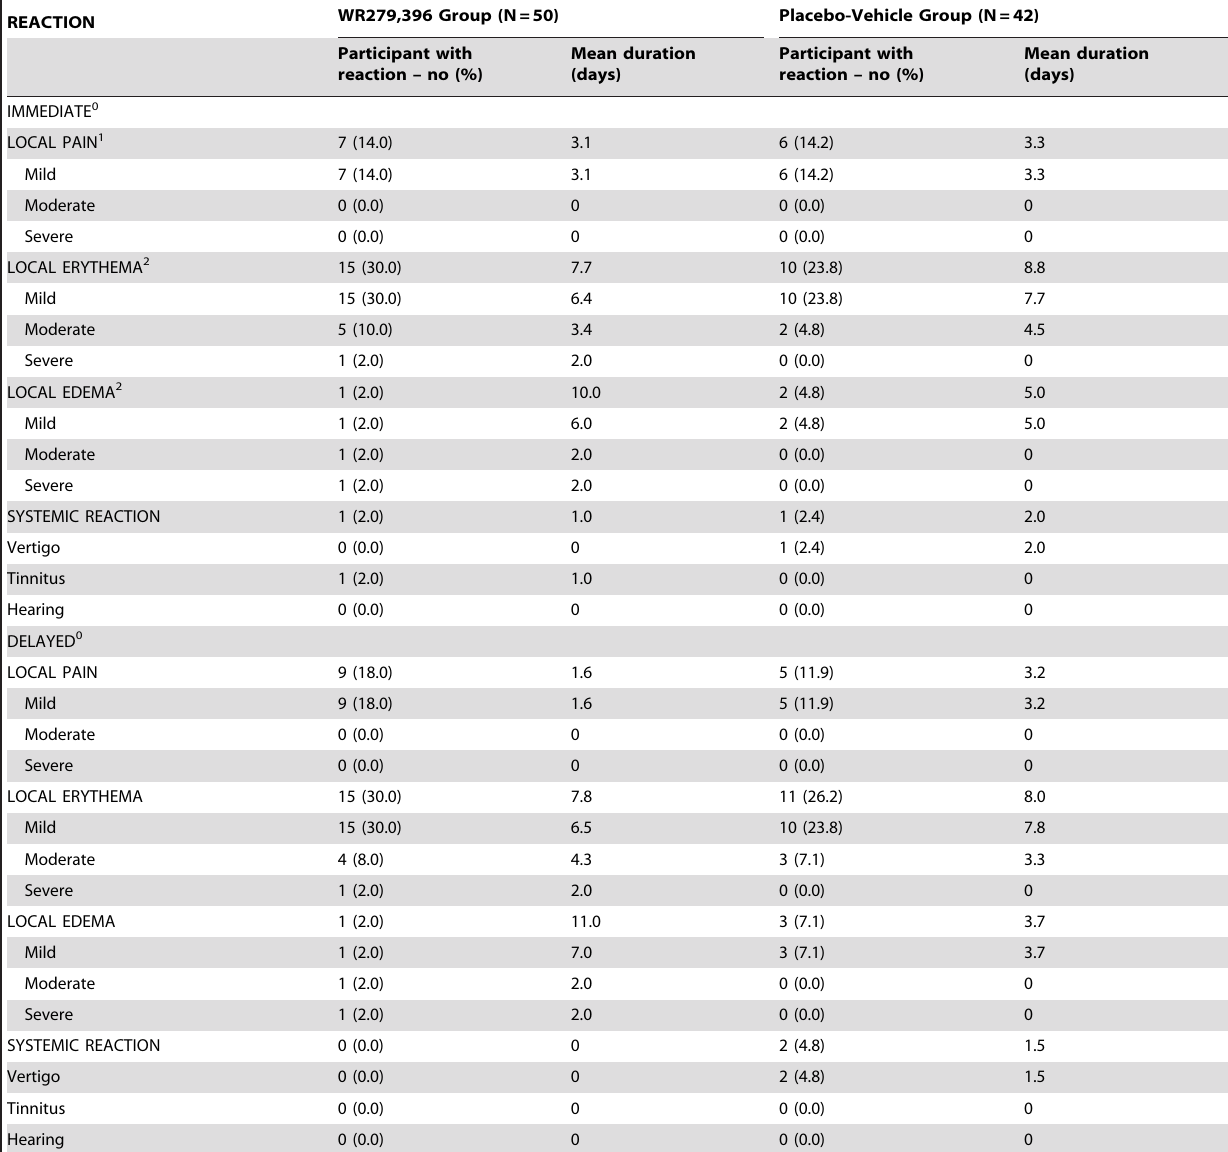
Table 4. Immediate & Delayed Local & Systemic